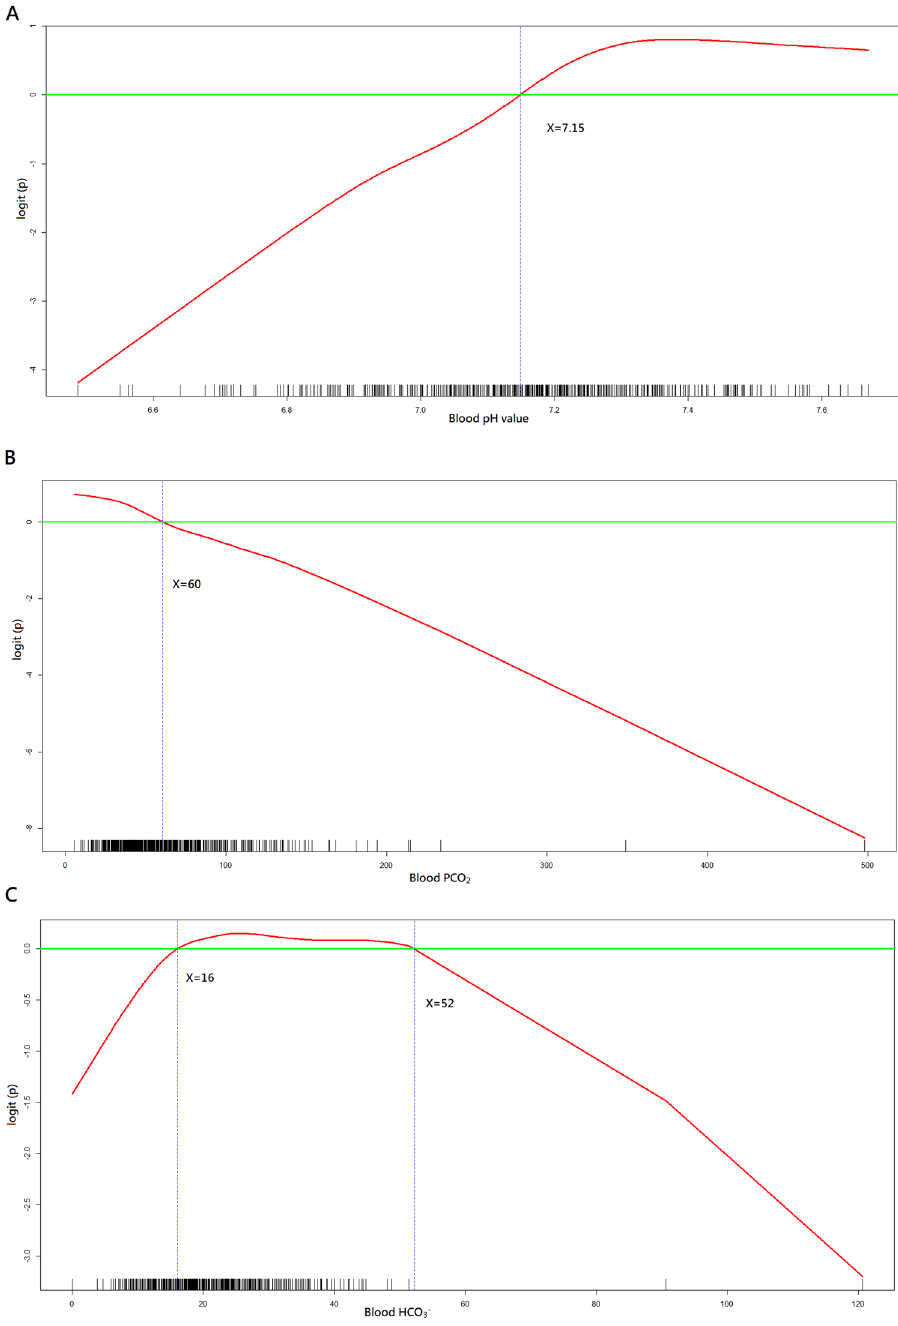
Figure 1. Generalised additive model plots for nonparametric modelling of the respective effect of ( A ) blood pH, ( B ) PCO 2 , and ( C ) HCO 3− on the logit of probability for favourable neurological outcome at hospital discharge. R Core Team (2019). R: A language and environment for statistical computing. R Foundation for Statistical Computing, Vienna, Austria. URL http:// www.R- proje ct.